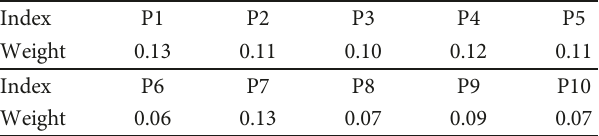
Table 5: Hierarchical total ranking weight distribution table.